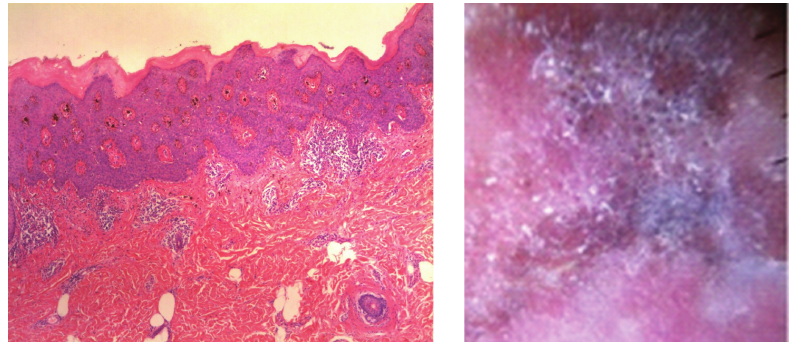
Figure 14: Case 2. H&E. Melanophages arranged in groups in the papillary dermis that correlate with brown globules and dilated capillary vessels correlate with glomerular vessels.